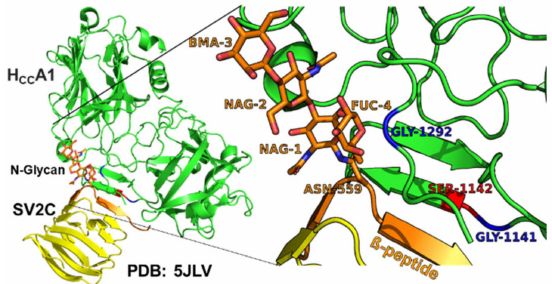
Figure 2. Three BoNT/A1-BoNT/A4 amino acid variants (G 1141 D, S 1142 N, and G 1292 R) located at the interface of BoNT/AH CC and β -peptide (brown) within LD4 of SV2C (PDB: 5JLV). The G 1141 D, S 1142 N, and G 1292 R variants of BoNT/A1 and BoNT/A4, respectively, were chosen for assessment, since Hcc/A1 G 1141 and S 1142 were adjacent to the β -peptide of Luminal Domain 4 (LD4) of SV2C, and Hcc/A1 G 1292 was located adjacent to the glycan network of glycosylated-N 559 (brown) within the β -peptide of LD4 of SV2C. Modeling of Hcc/A4 showed the location of D 1141 (red), N 1142 (blue), and G 1292 (blue) PDB: